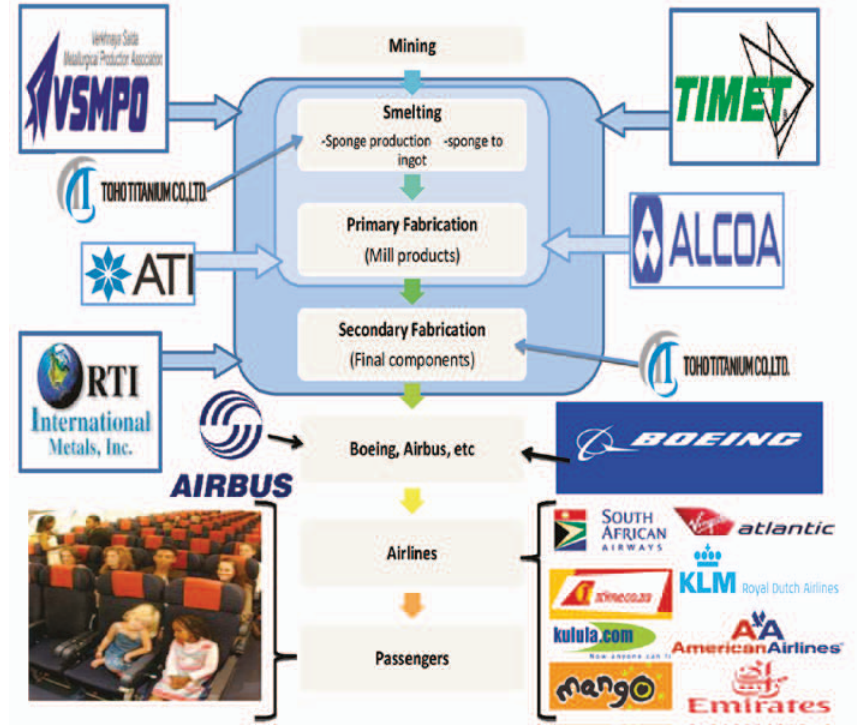
Figure 1: Global commercial aircraft titanium process flow with